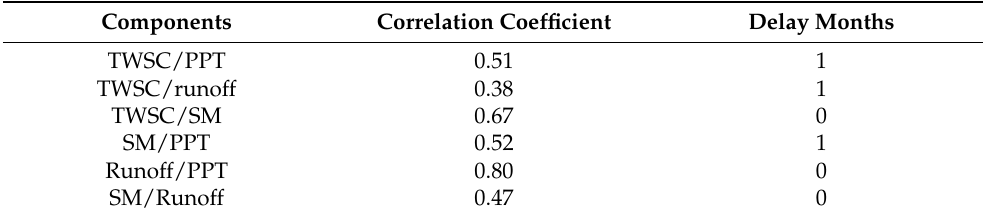
Table 6. The maximum correlation coefficients and the corresponding time delay months between TWSC, PPT, SM, and runoff anomaly in the MLY (these results have passed the 95% confidence level). Components Correlation Coefficient Delay Months TWSC/PPT 0.51 1 TWSC/runoff 0.38 1 TWSC/SM 0.67 0 SM/PPT 0.52 1 Runoff/PPT 0.80 0 SM/Runoff 0.47